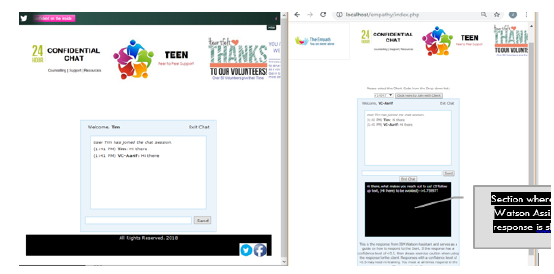
Figure 13. Client can exchange Chat Messages